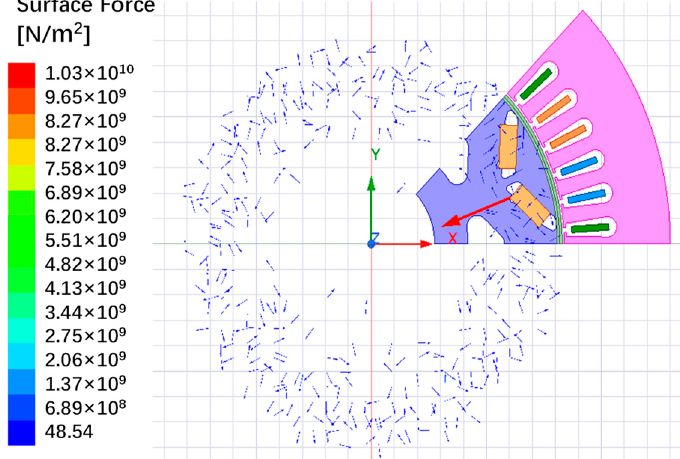
Figure 4. Electromagnetic force density distribution diagram.